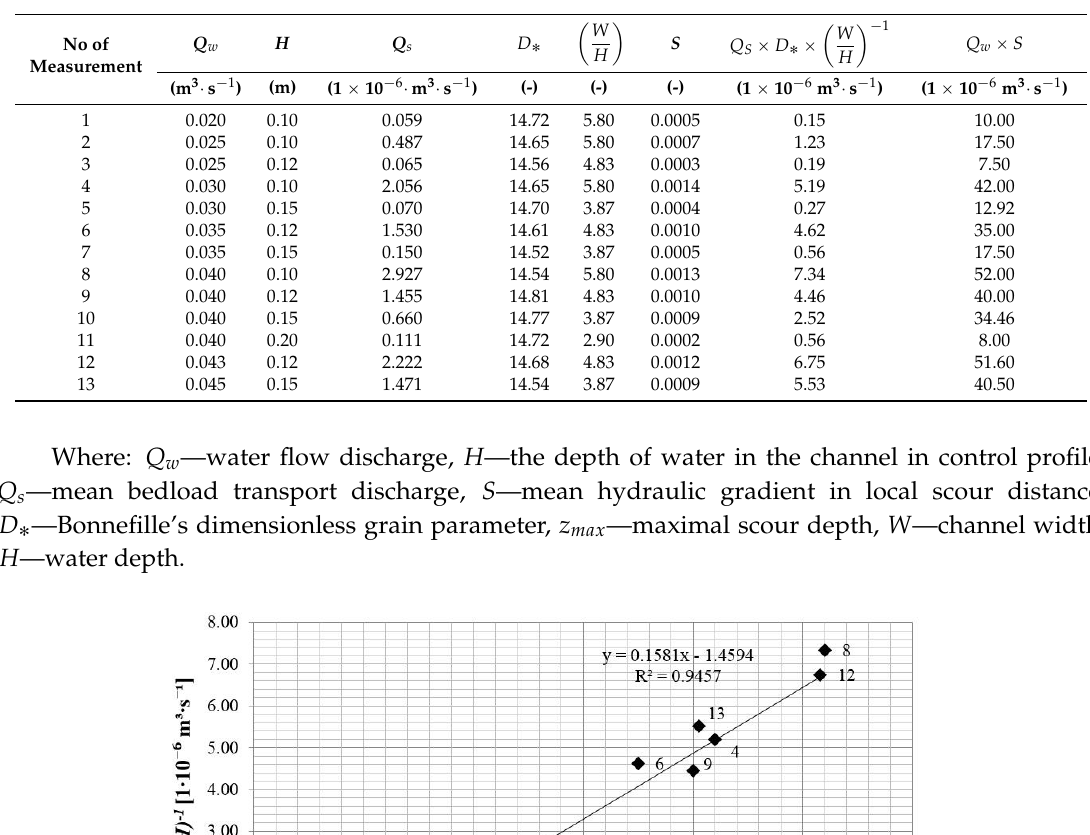
Table 2. Summary of calculation results.